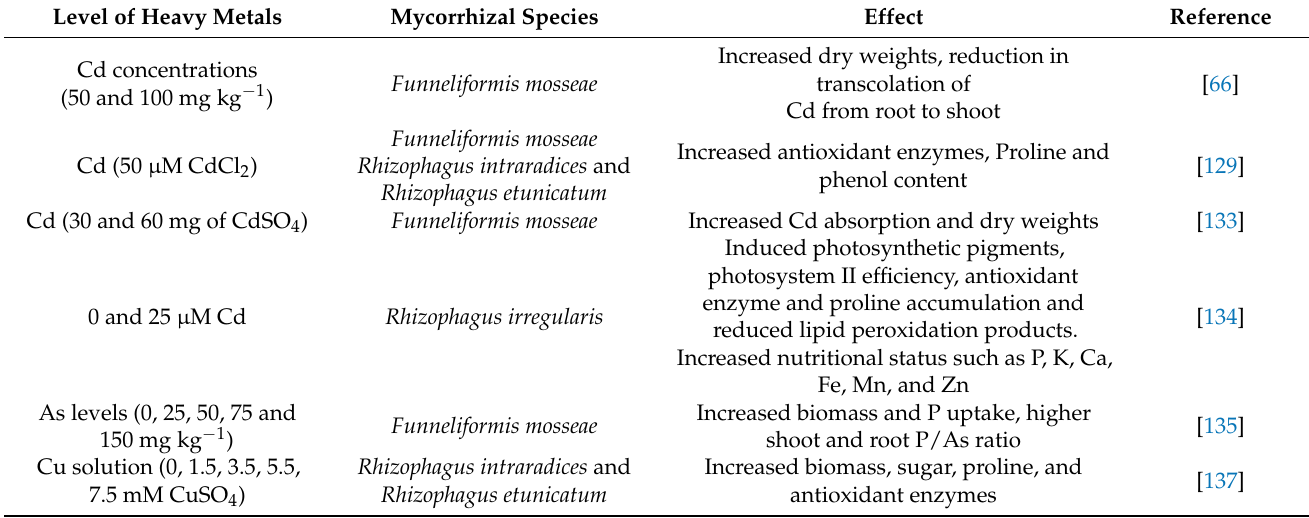
Table 4. Application of arbuscular mycorrhizal fungi on heavy metal stress